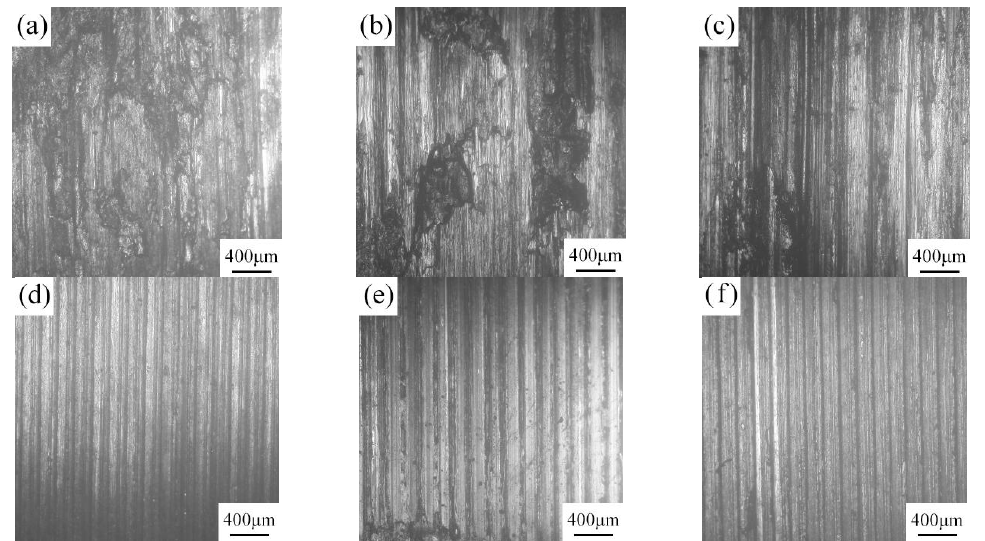
Figure 7. Two-dimensional friction surface morphology of tin bronze ( a – c ) and tin bronze-based ISSLB materials ( d – f ), ( a , d ) 100 N, ( b , e ) 300 N, ( c , f ) 500 N.